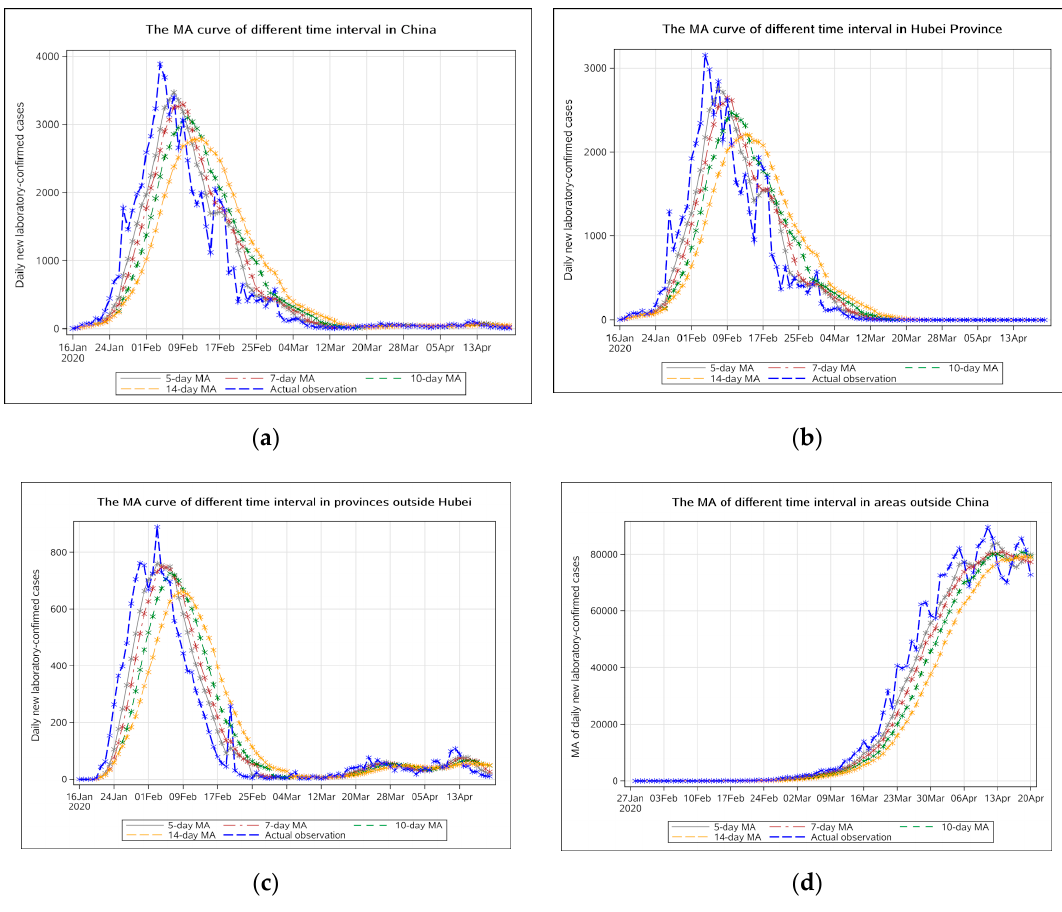
Figure A1. The 5-day, 7-day, 10-day, and 14-day MA of daily new laboratory-confirmed cases, from 16 January to 20 April 2010. ( a ) In China; ( b ) In Hubei Province; ( c ) In provinces outside Hubei; and ( d ) In areas outside China.